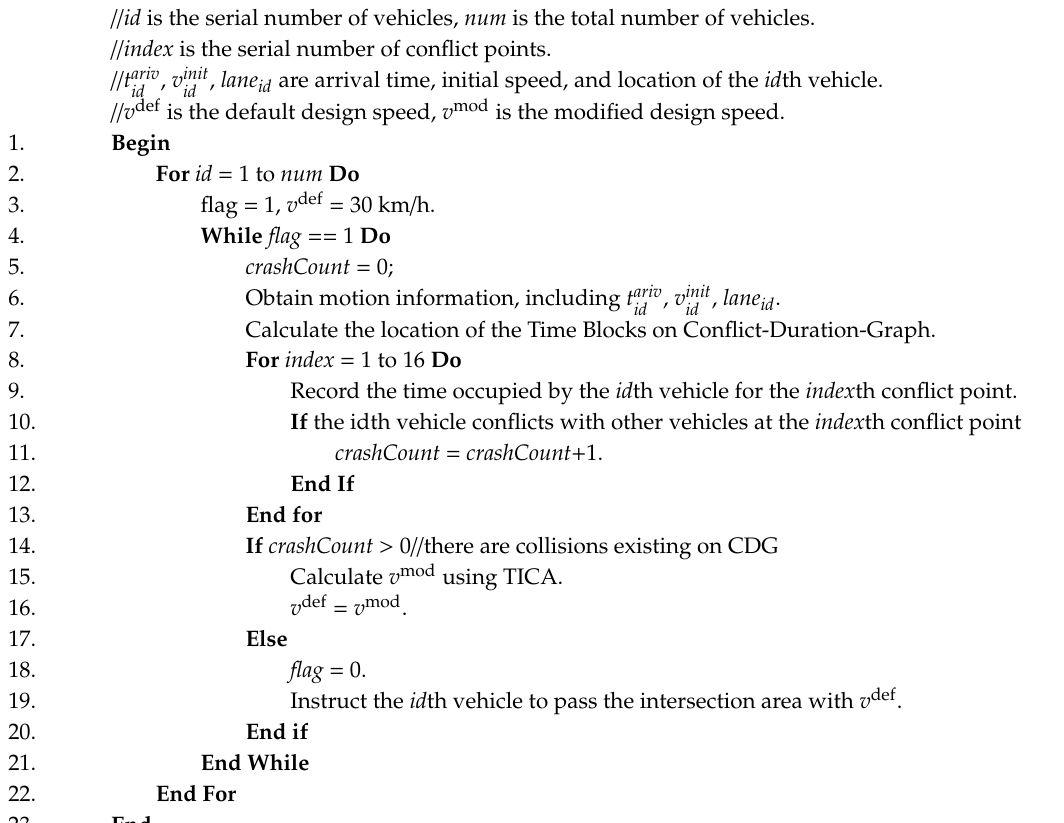
Algorithm 1 Conflict detection and resolution